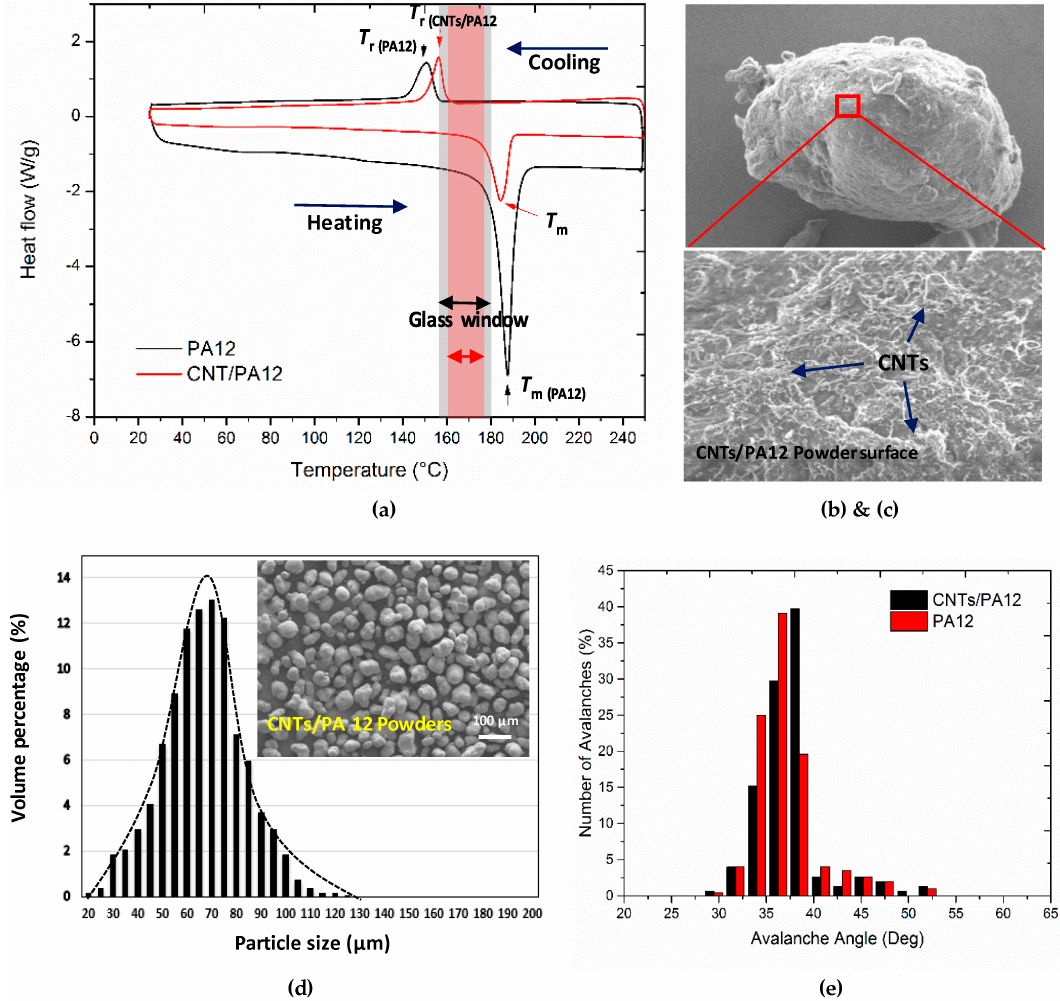
Figure 2. ( a ) DSC diagrams of PA12 and CNTs/PA12 upon heating and cooling at the rate of 10 °C/min; ( b ) size distribution of PA12 and CNTs/PA12 (0.5 wt %); SEM images of ( c ) the SEM image of an entire composite powder and then zoomed in to investigate the surface coating of CNTs; ( d ) the surface layer of CNTs which are lighten network structure; ( e ) avalanche angle graph indicating the required average angle to start and maintain the flow of the PA12 and CNTs/PA12 powders.